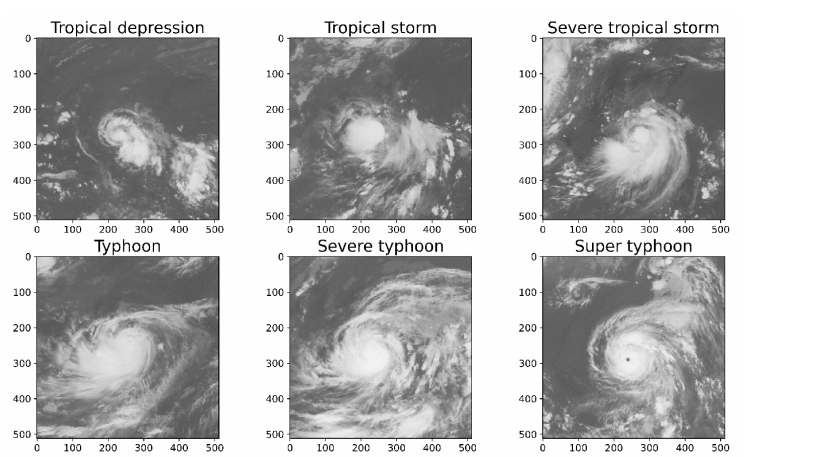
Figure 2. Details of dataset processing.